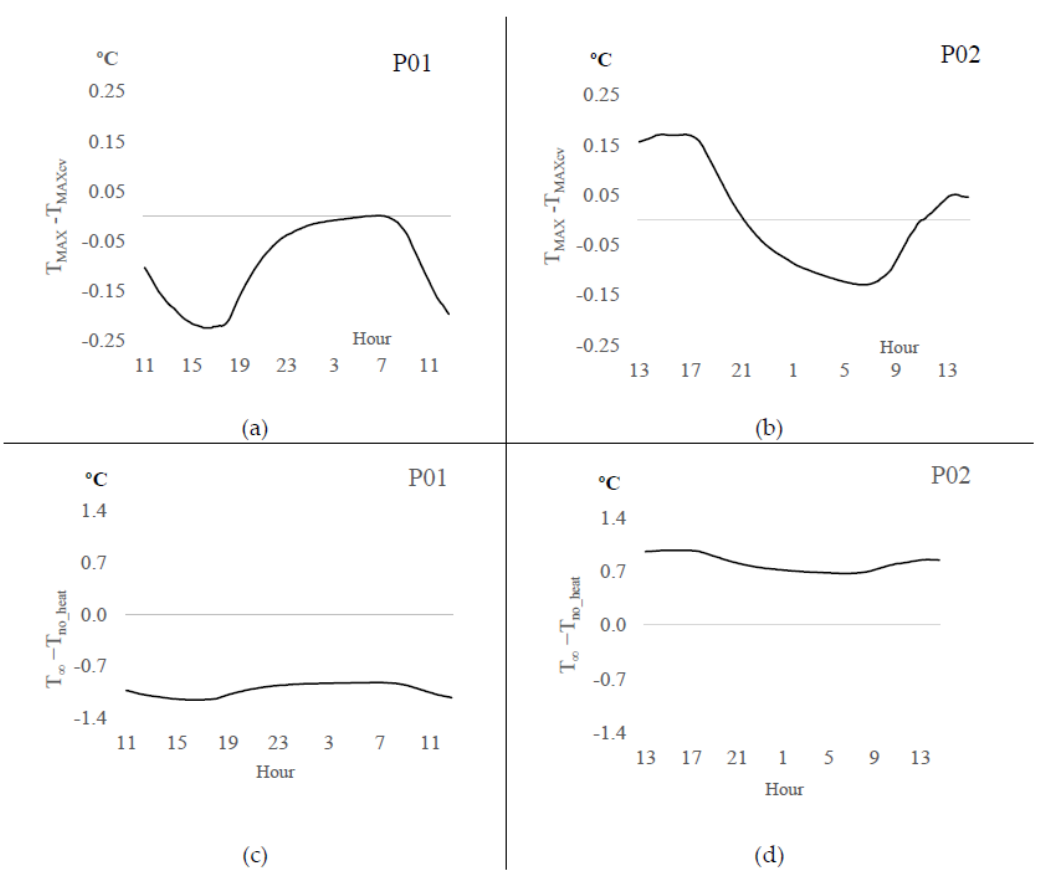
Figure 4. Comparison between Biot-Granier and conventional Granier approaches (Experiment I). ( a )